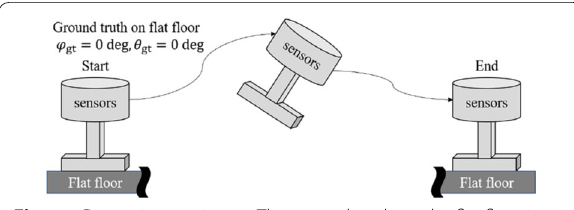
Fig. 14 Dynamic experiment. The ground truth on the flat floor is assumed to be 𝜙 gt = 0 deg, 𝜃 gt = 0